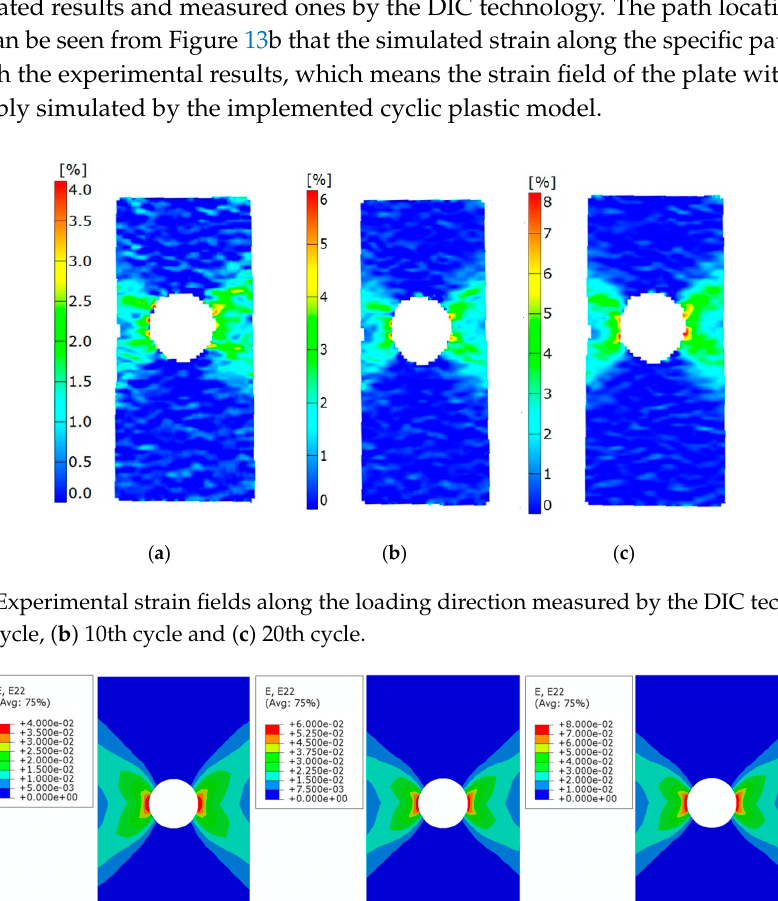
Figure 12. Simulated strain fields in the ( a ) 1st cycle, ( b ) 10th cycle and ( c ) 20th cycle.